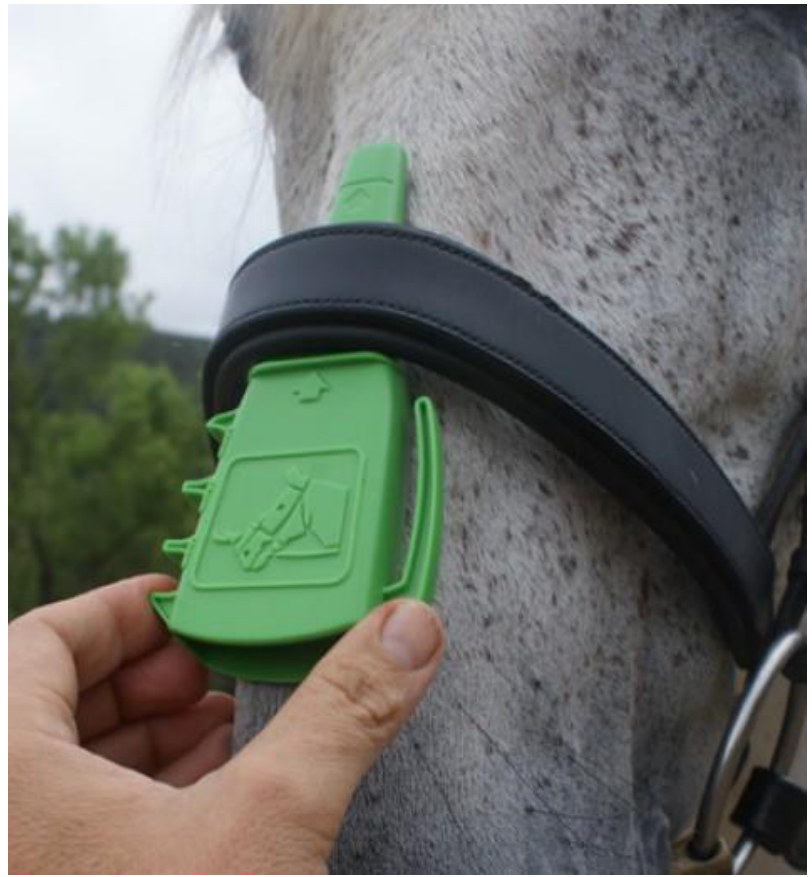
Figure 1. The ISES Noseband Taper Gauge being used to measure a noseband on the frontal nasal plane of the horse—the raised stop mark indicates how far the device should be able to be inserted under the noseband to indicate proper two-finger (1.5 cm) fit. Photo courtesy of ISES.